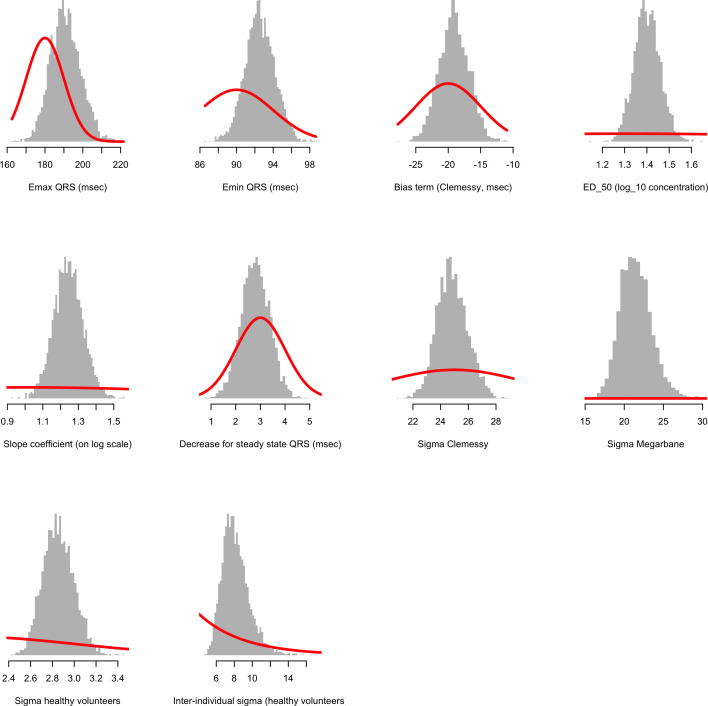
Comparison between prior distributions (thick red lines) and posterior distributions (shown as histograms) for the population parameters of the concentration-QRS duration Emax sigmoid regression model.